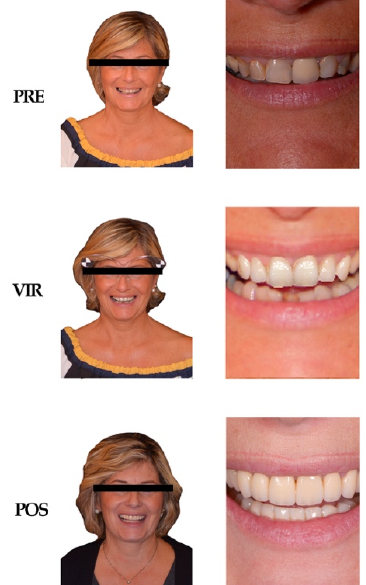
Figure 1. Standard set of participants’ photos: Photos of one of the participant’s portrait in the three phases of the treatment (from above PRE–VIR–POST). Each phase was featured by two different photographs: one showing the patient in frontal position (left column), and one showing the middle third of the patient’s face (right column).